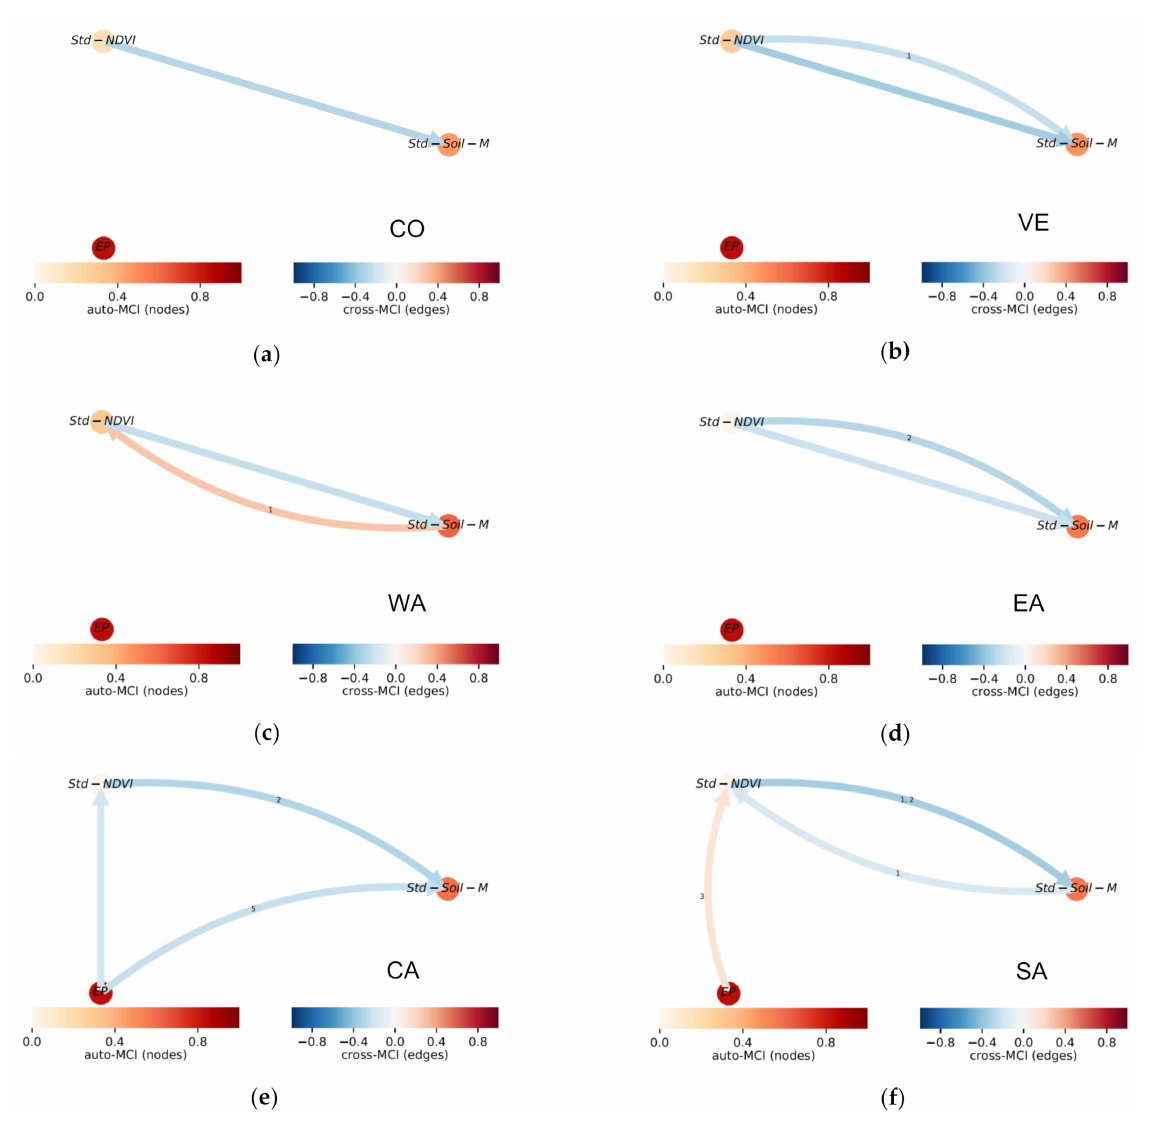
Figure 14. Nonlinear causality analysis based on PCMCIplus between the standardized monthly series of NDVI and SMOS, and the Eastern Pacific (EP) index. Node colors denote the nonlinear auto-dependency of each variable, whereas the colors of the lines denote the cross-MCI between both variables and the horizontal lines denotes the simultaneous nonlinear co-dependency. ( a ) CO: Colombia, ( b ) VE: Venezuela, ( c ) WA: West Amazonia, ( d ) EA: East Amazonia, ( e ) CA: Center Amazonia, and ( f ) SA: South